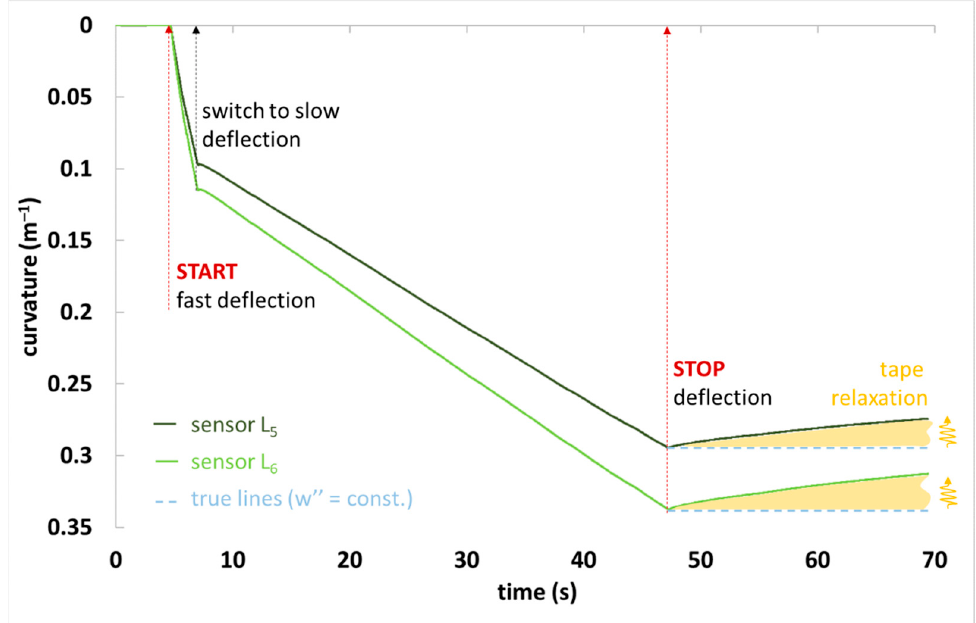
Figure A3. Temporal change of the signal from sensor L 4 and L 5 during the quasi-static deformation on the bending machine. At the end of the deflection, the relaxation process of the sensor signals due to the viscoelastic behavior of the tape is visible.